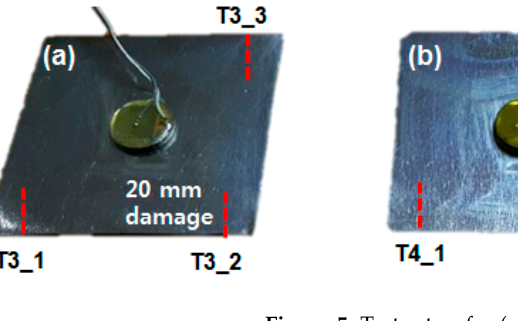
Figure 6. Impedance signatures for the T3_1, T3_2 and T3_3 experiment.